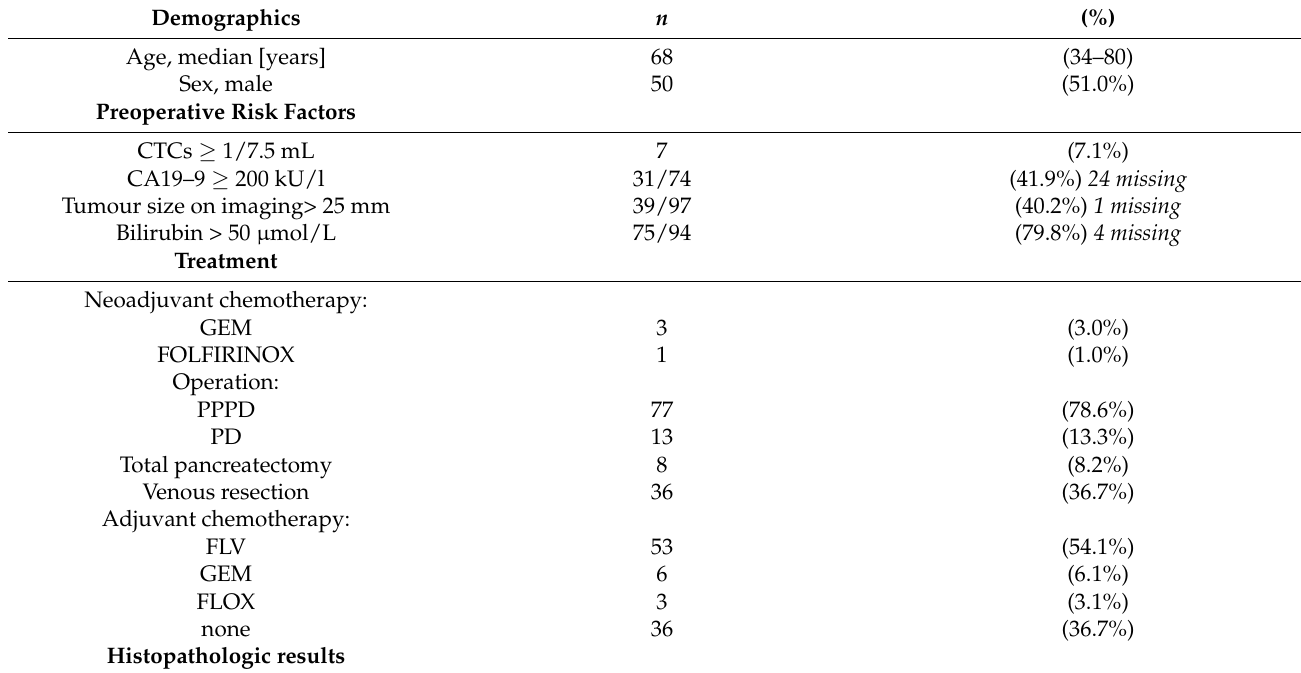
Table 1. Clinicopathological parameters for resected PDAC ( n =